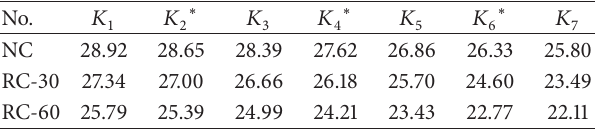
Table 5: Data for building the grey model (MPa).